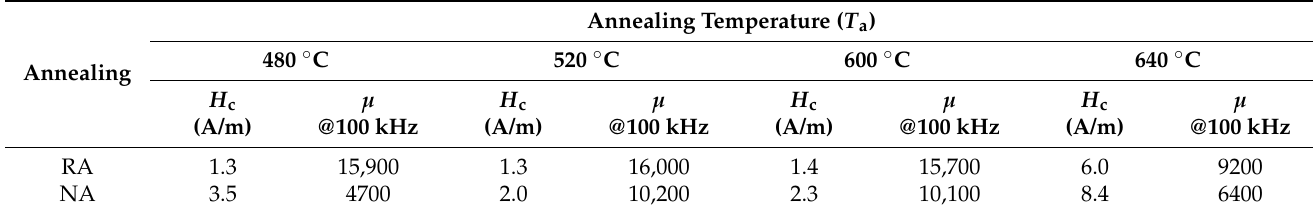
Table 1. μ at 100 kHz and H c of Mn2 by RA and NA at different T a . Table 1. µ at 100 kHz and H c of Mn2 by RA and NA at different T a